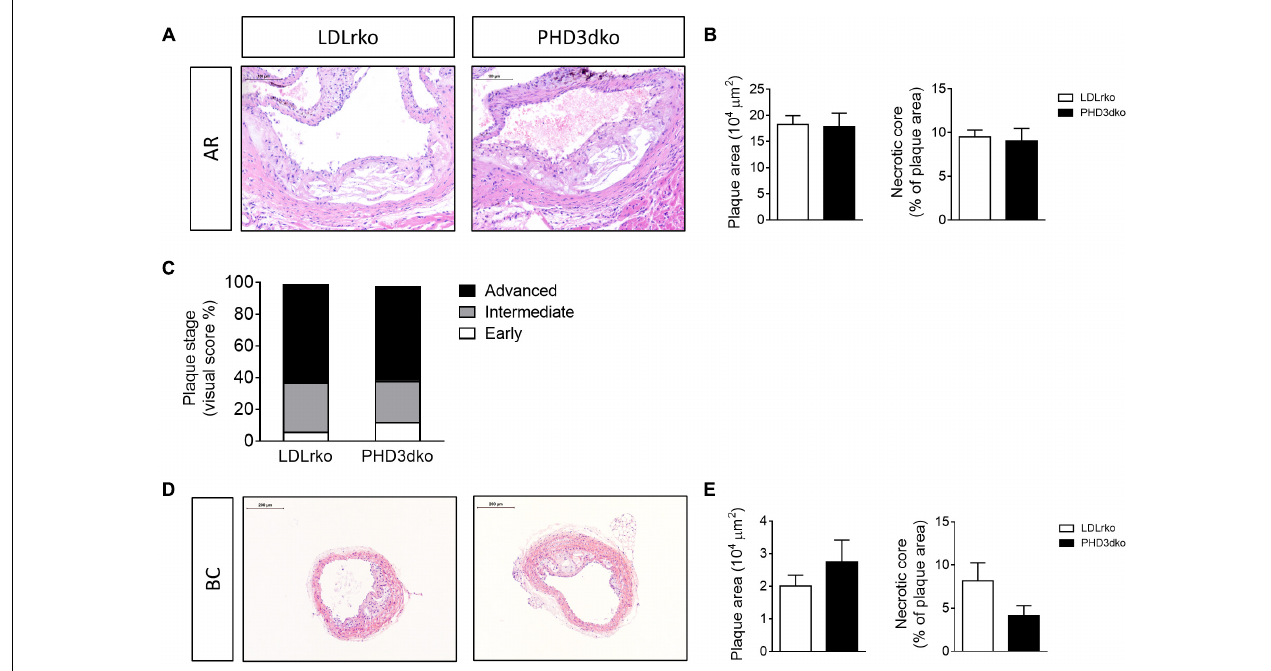
FIGURE 3 | PHD3dko did not change plaque size or necrotic content. (A) Representative microphotographs of H&E stained sections of aortic root (AR) (PHD3dko n = 18, LDLrko n = 10) and (B) quantification of plaque size and necrotic plaque content. (C) Plaque stage represented as early, intermediate, or advanced. (D) Representative microphotographs of H&E stained sections of brachiocephalic artery (BC) (PHD3dko n = 21, LDLrko n = 13), and (E) quantification of plaque size and necrotic plaque content. Scalebar represents 100 µ m in AR and 200 µ m in BC photographs.